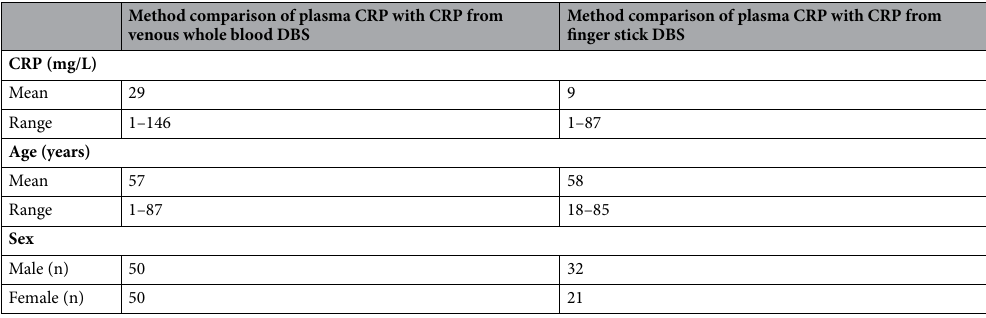
Table 1. Study population